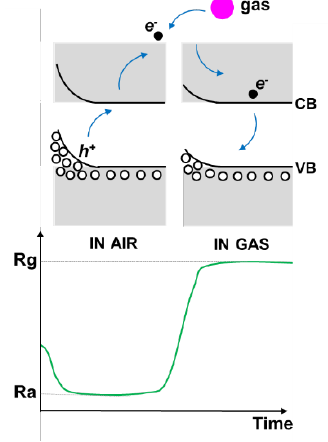
Figure 8. Schematic illustration of the change of CuO electrical resistance upon exposure to air ( left ) and a reducing gas ( right ). CB: conduction band minimum. VB: Valence band maximum. Ra: Resistance in air. Rg: Resistance in gas. e − : electrons. h + : holes.